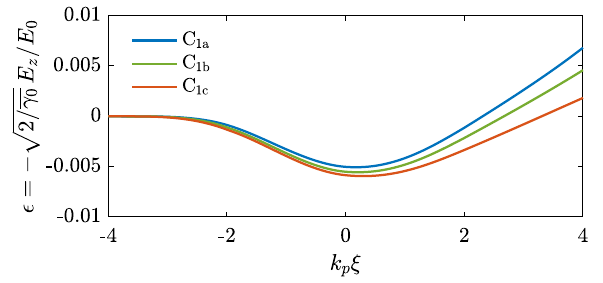
FIG. 4. The relative energy change per betatron cycle ϵ ¼ ffiffiffiffiffiffiffiffiffi p − 2 = ¯ γ =E E 0 z 0 as a function of the comoving coordinate cases C 1 (blue), C 1 (green), and C 1 a b